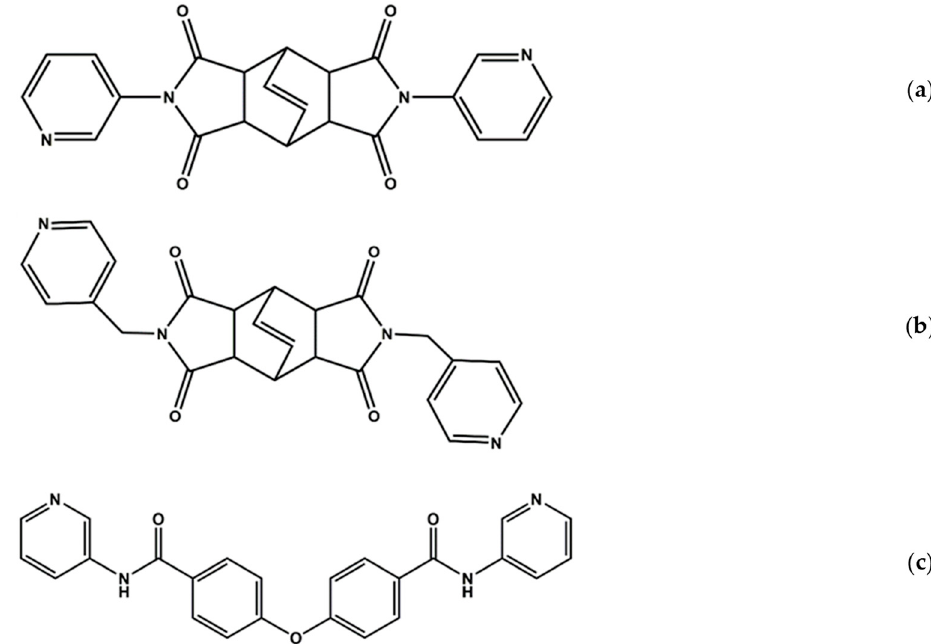
Figure 1. Structures of ( a ) L 1 , ( b ) L 2 , and ( c ) L 3 .